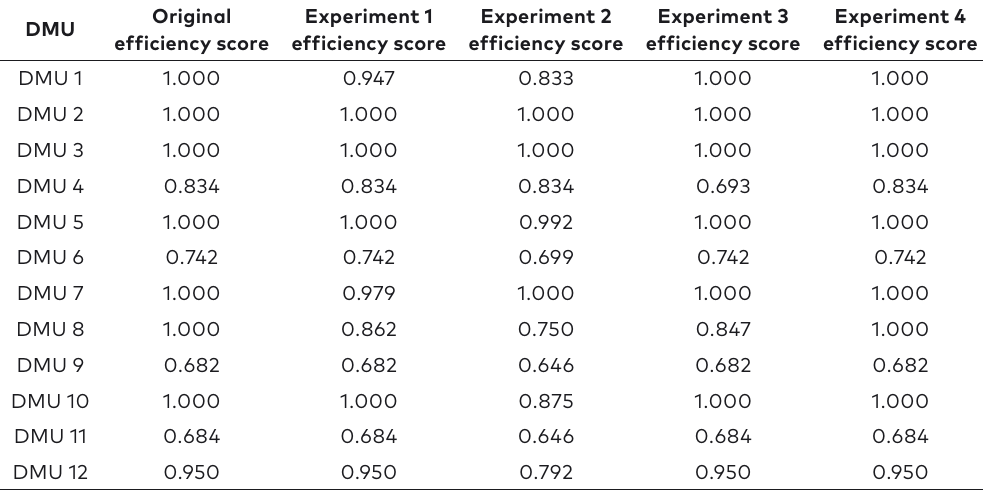
Table 7. Results of sensitivity